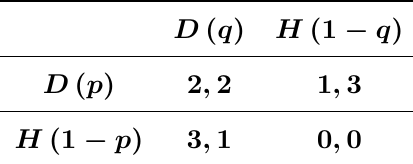
Table 1. A hawk-dove